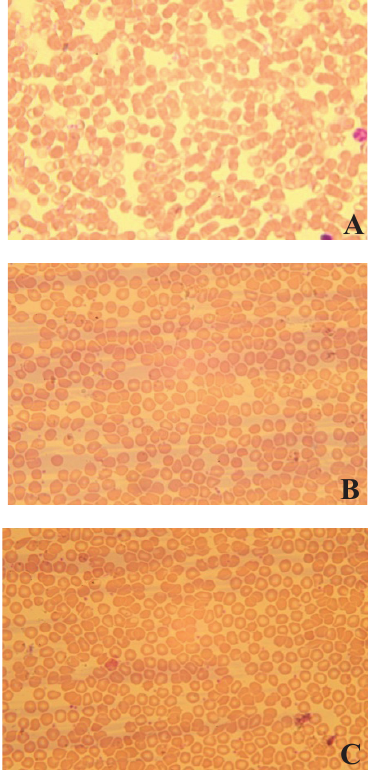
FIGURE 1 – Photomicrography of red blood cells from ( A ) colectomy, ( B ) colectomy +hepatectomy and ( C ) sham rats.